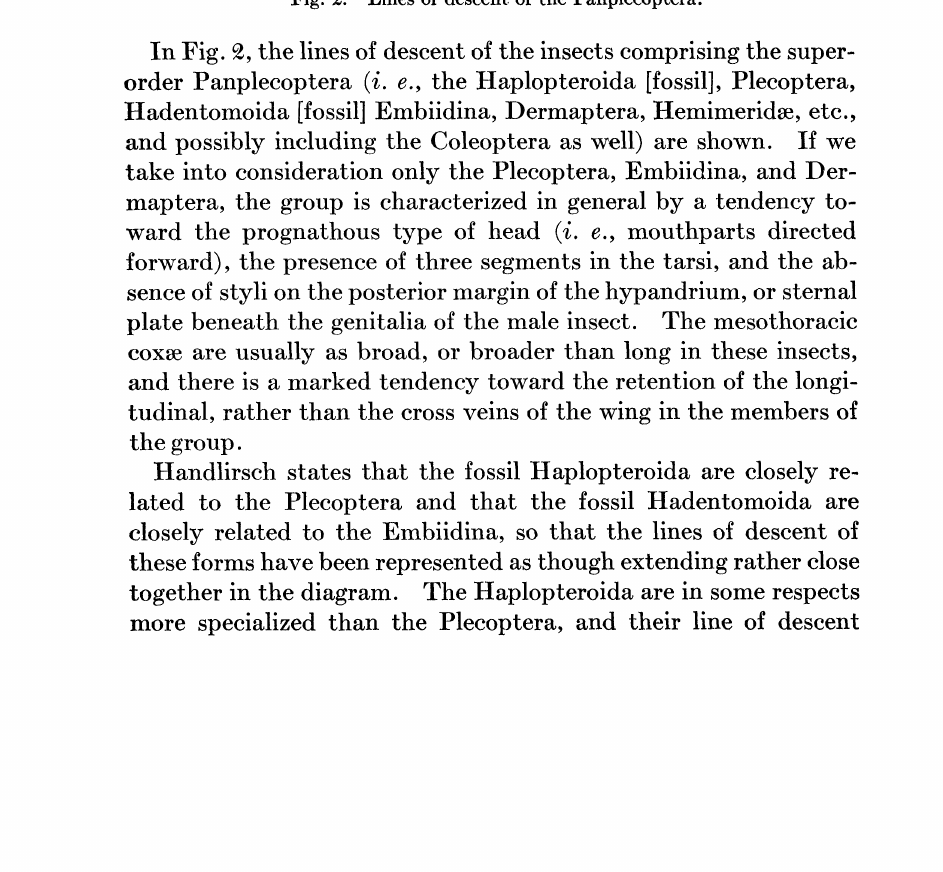
Fig. 2. Lines of descent, of the